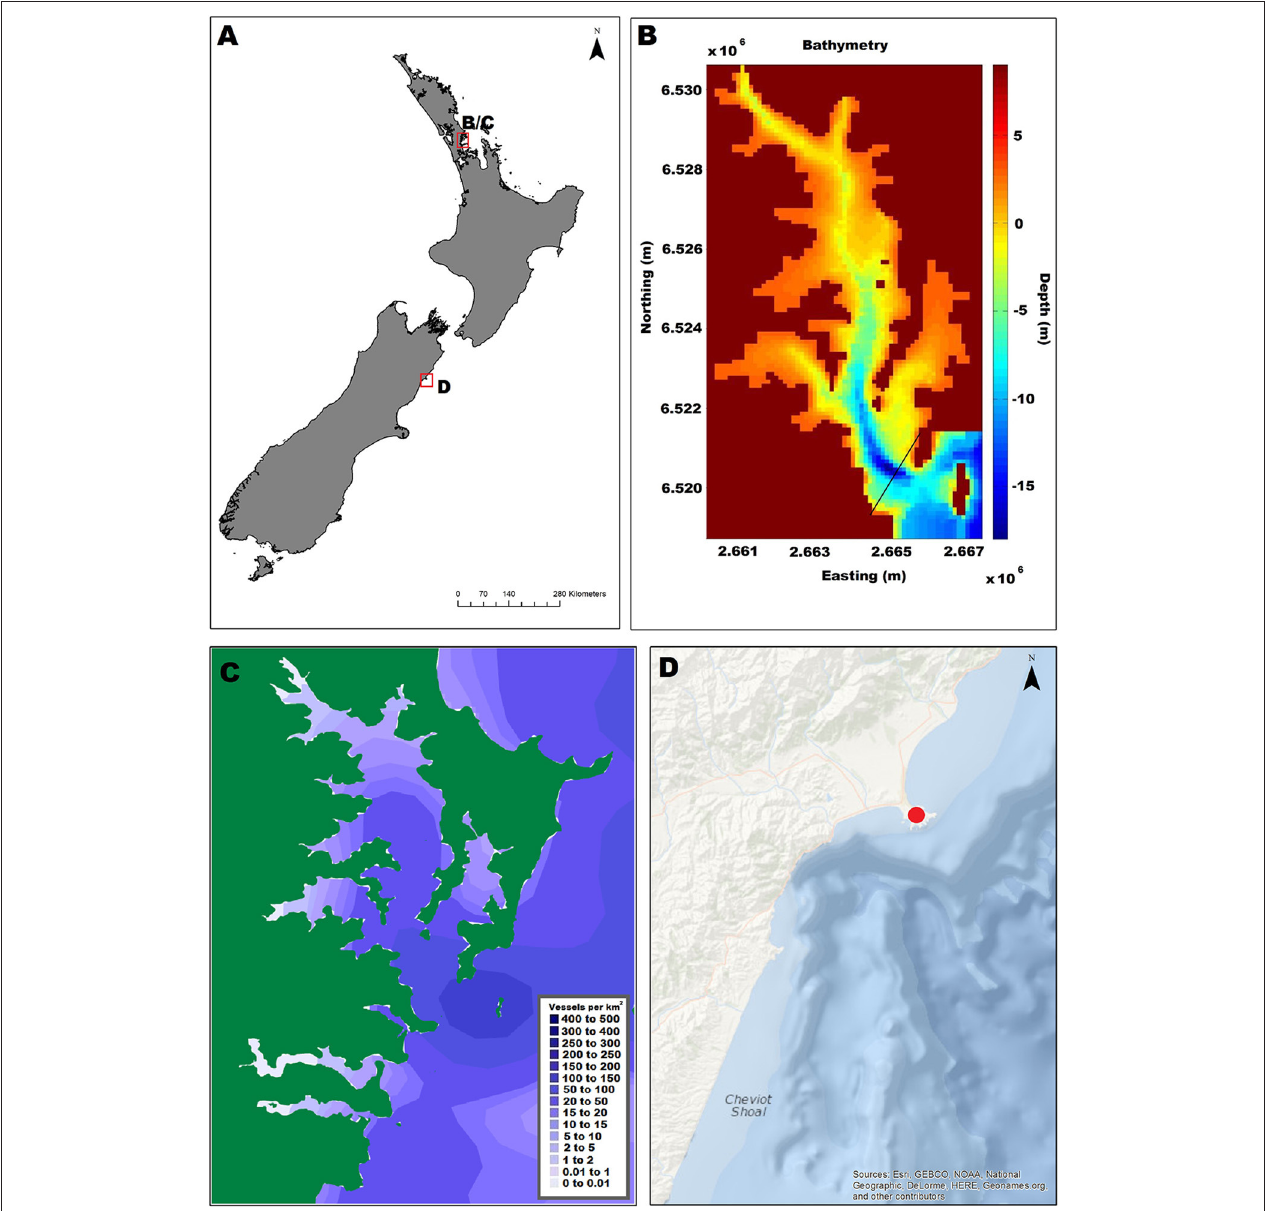
FIGURE 2 | (A) Map of New Zealand with the positions of Mahurangi Harbor (B,C) and Kaikoura Peninsula (D) indicated. Panel B presents the bathymetry of Mahurangi Harbor where the most productive waters are intertidal (orange-red) and shallow subtidal (yellow) and located in the main arms and upper reaches of the harbor. The centers of productivity contrast sharply with the areas of highest fishing intensity which are outside of the harbor mouth and in the main harbor channel, shown in Panel C from aerial surveys of recreational fishing effort (NABIS, http://www.nabis.govt.nz). Panel D shows the Kaikoura Peninsula (red circle) and the topography of the region with deep trenches south of the peninsula where cetaceans